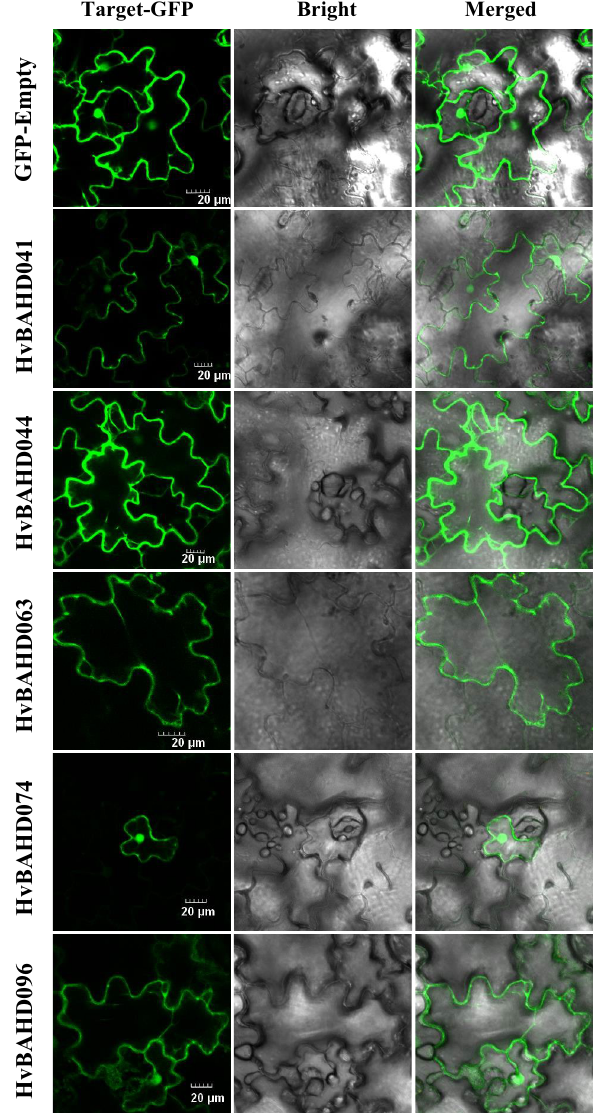
Figure 10. Subcellular localization of HvBAHD proteins in barley. Selected HvBAHD-GFP fusion protein as well as GFP-Empty as the control were independently transiently expressed in tobacco leaves and imaged under a confocal microscope. Bars, 20